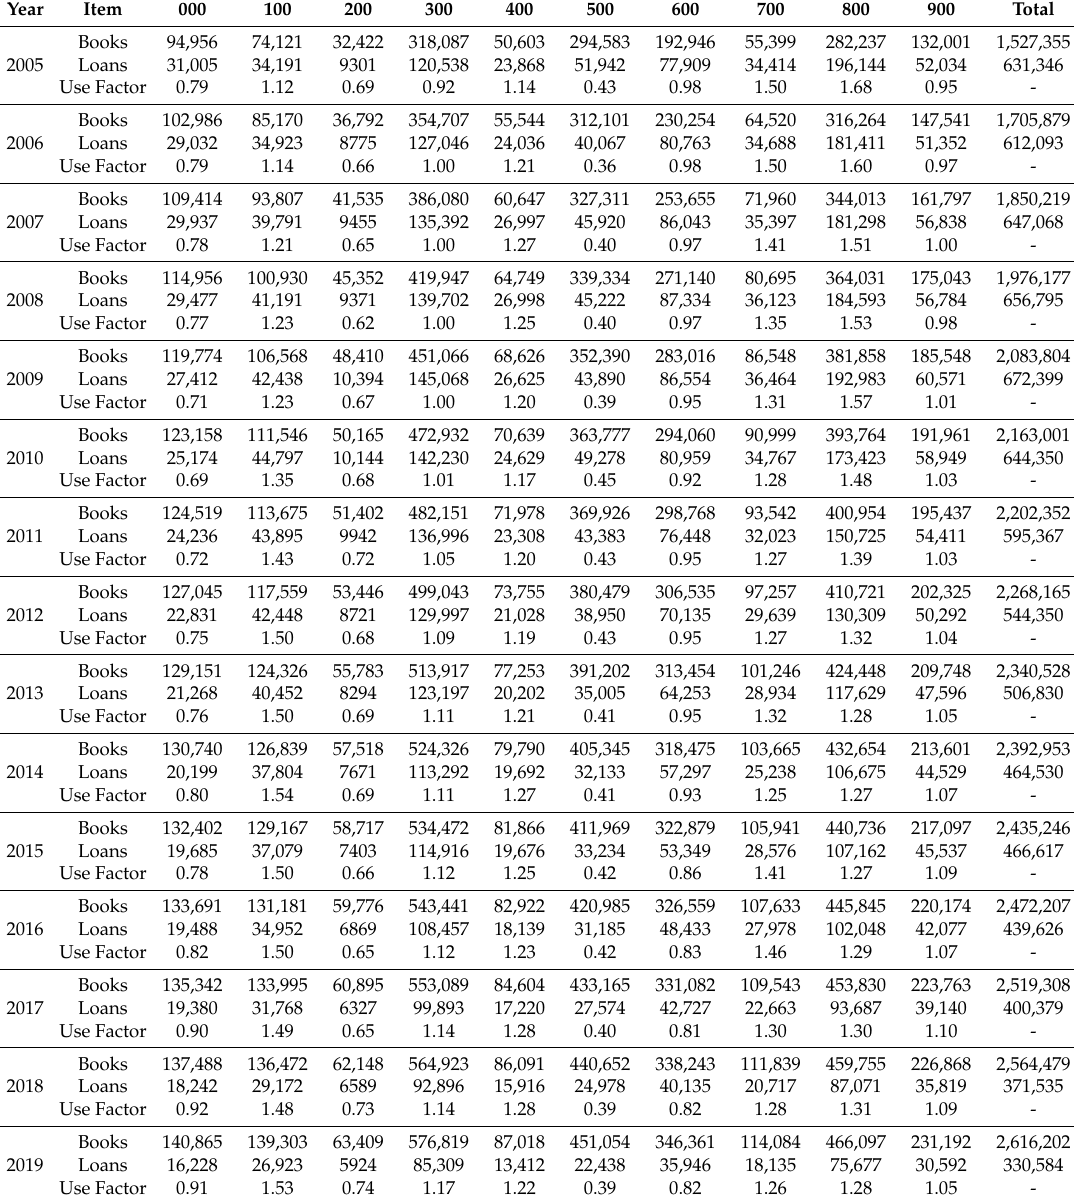
Table 1. The numbers of books and loans and the use factor in each Dewey decimal classification (DDC) class for each